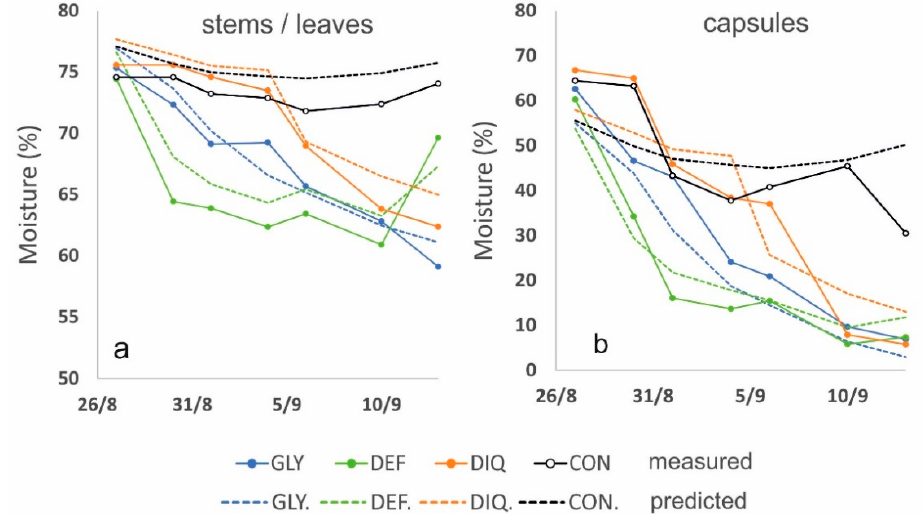
Figure 11. Changes in moisture content of stems and leaves ( a ) and capsules ( b ) for the four alter- native treatments. Solid lines indicate the measured values and dotted lines the predicted values from the NDVI model. (GLY = Glyphosate 27/8, DEF = Spotlight ® 27/8, DIQ = Diquat 4/9 and CON = Control).